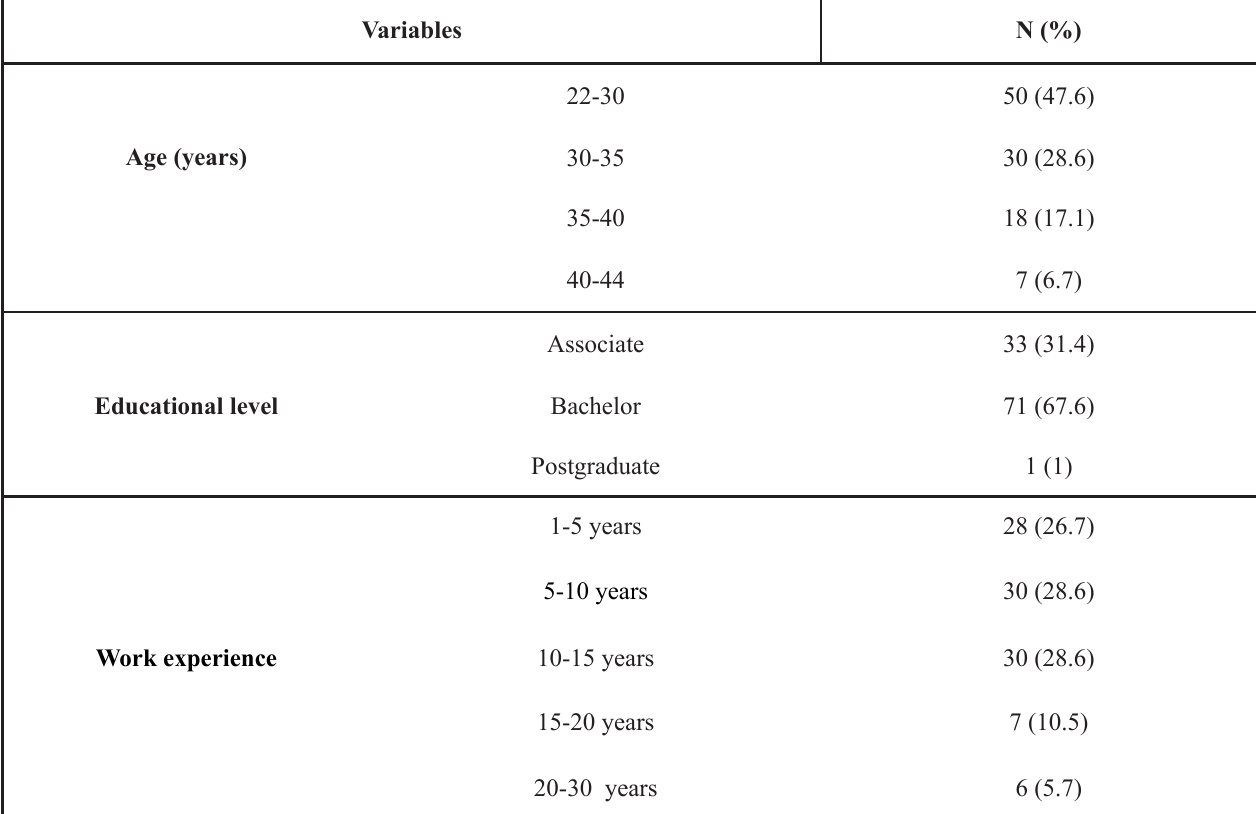
Table 1. Some demographic characteristics of subjects